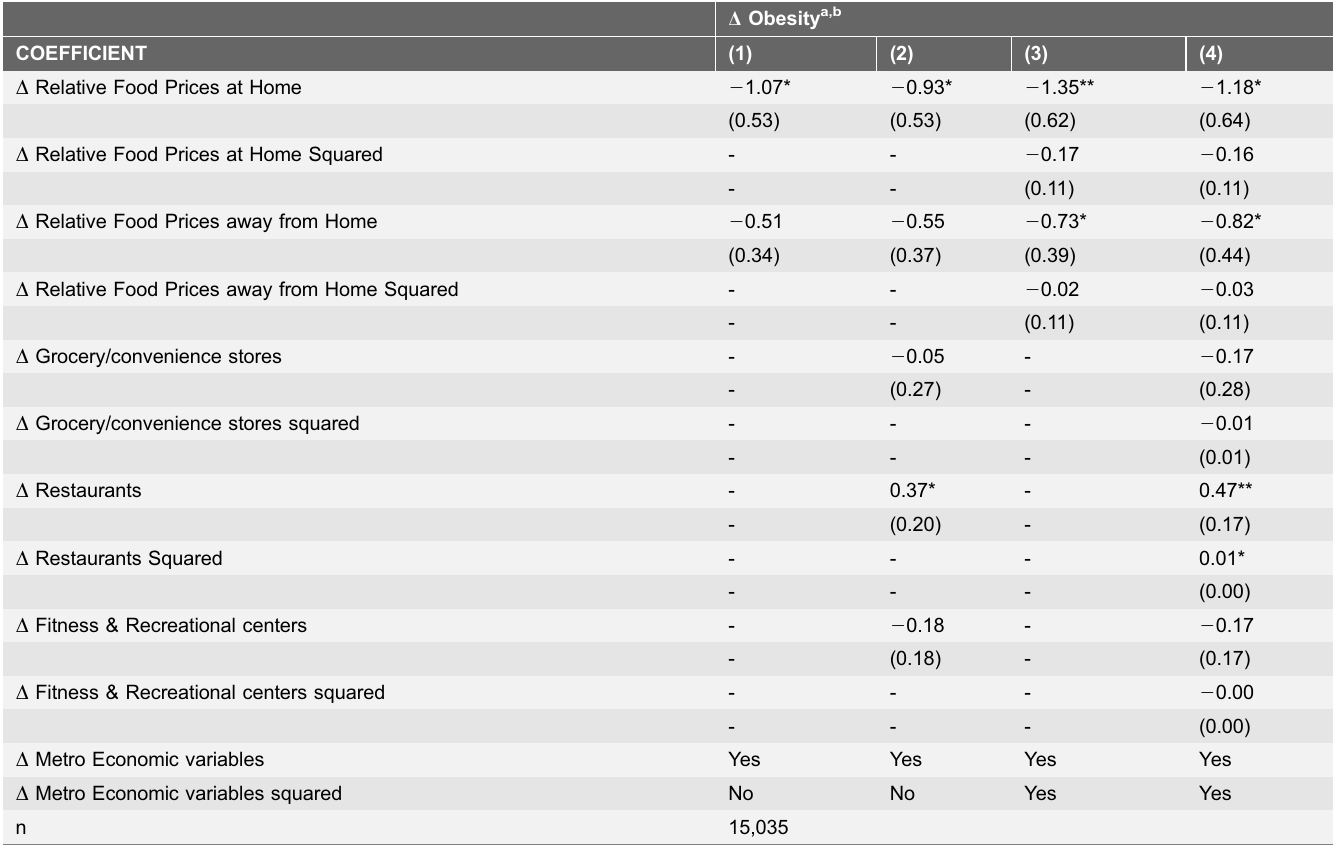
Table 3. The Estimated Effects of Relative Food Price Changes on